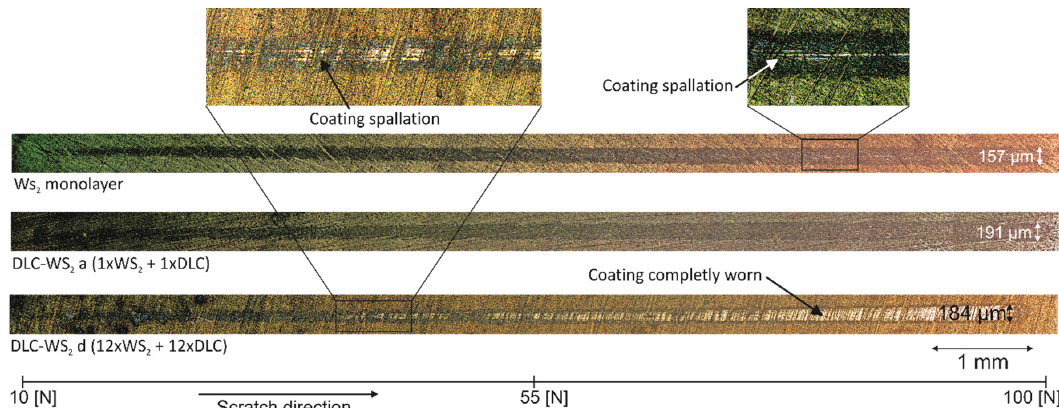
Figure 7 Figure 7. Optical microscope images of scratches after the ball-on-flat frictional test with WC ball for progressive increasing load 5–100